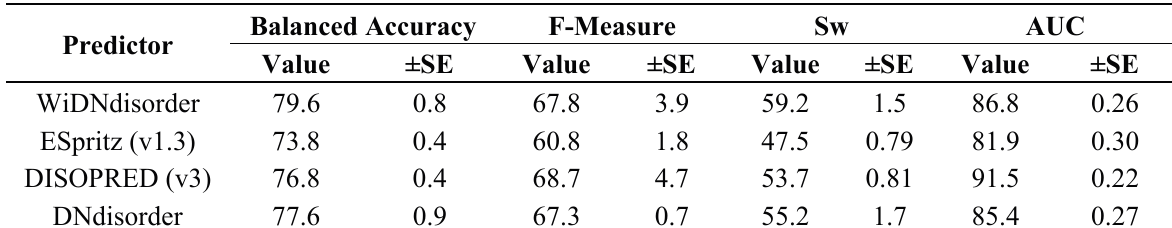
Table 1. Performance of WiDNdisorder (wide deep network disorder predictor) on the DO1111_TEST dataset.